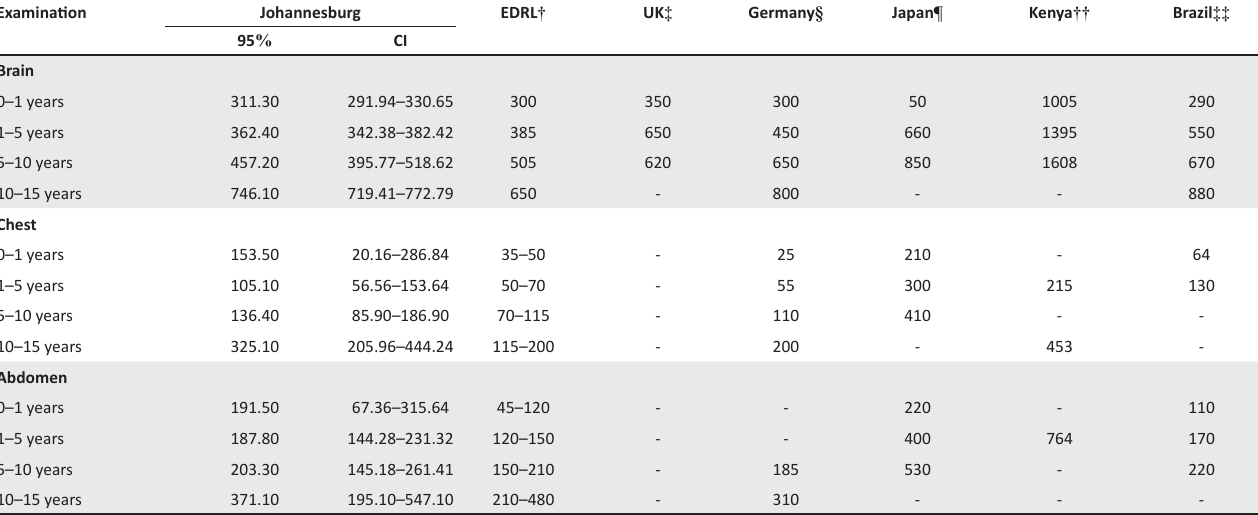
TABLE 8: Dose Length Product 75th percentile (mGy * cm) of Johannesburg hospitals compared to international diagnostic reference levels.